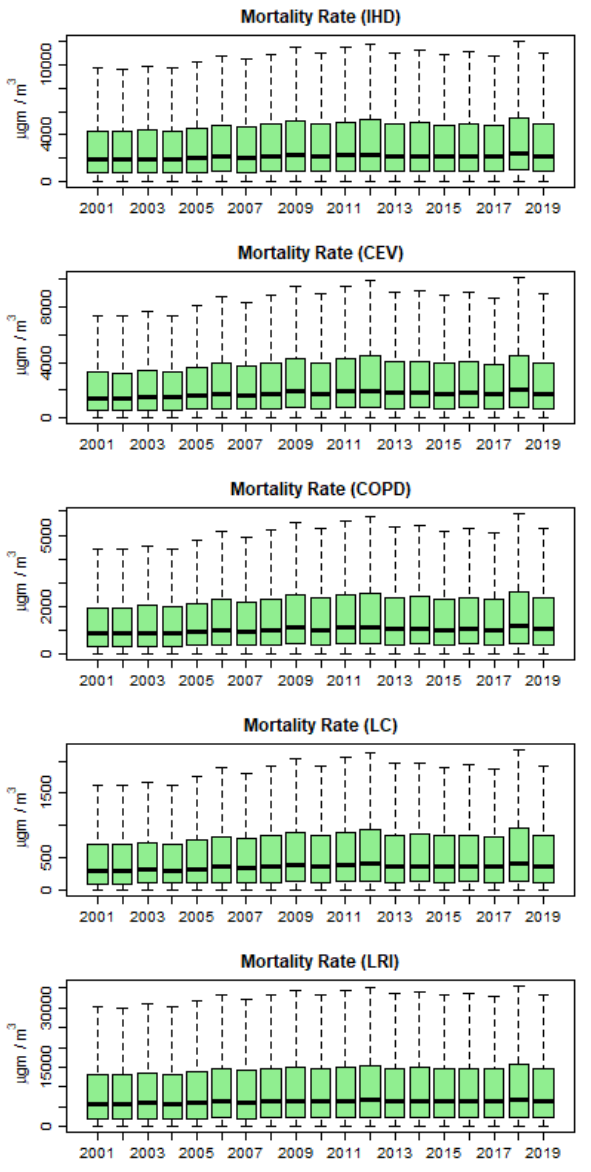
Figure 8 . Changes in excess mortality due to PM 2.5 , 2001– 2019.